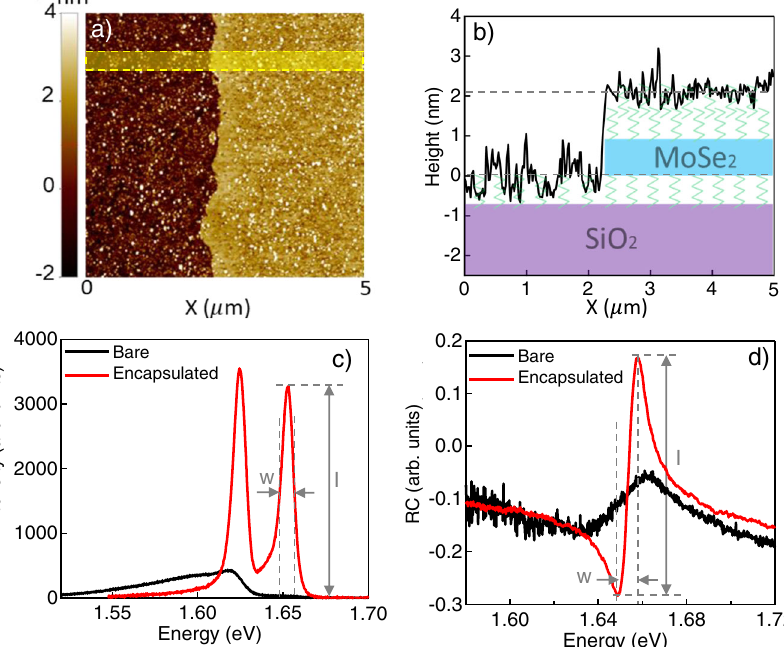
Fig. 1 | Molecular encapsulation of transition metal dichalcongenides (TMD) macroscopic monolayer (MML) for optical property enhancement. a Atomic force microscopy (AFM) image of D/MoSe 2 /D MML over a 5×5 µ m 2 area. b The height of the sample surface measured by AFMalong the x-axisand averaged over theyellowshadedregionmarkedin( a ),superposedoveraschematicofthesample